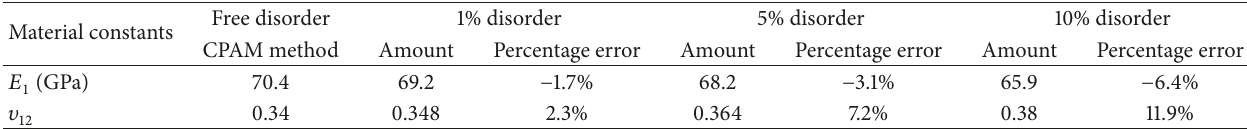
Table 10: Elastic constants determined for specimen A2 for different levels of disorder.